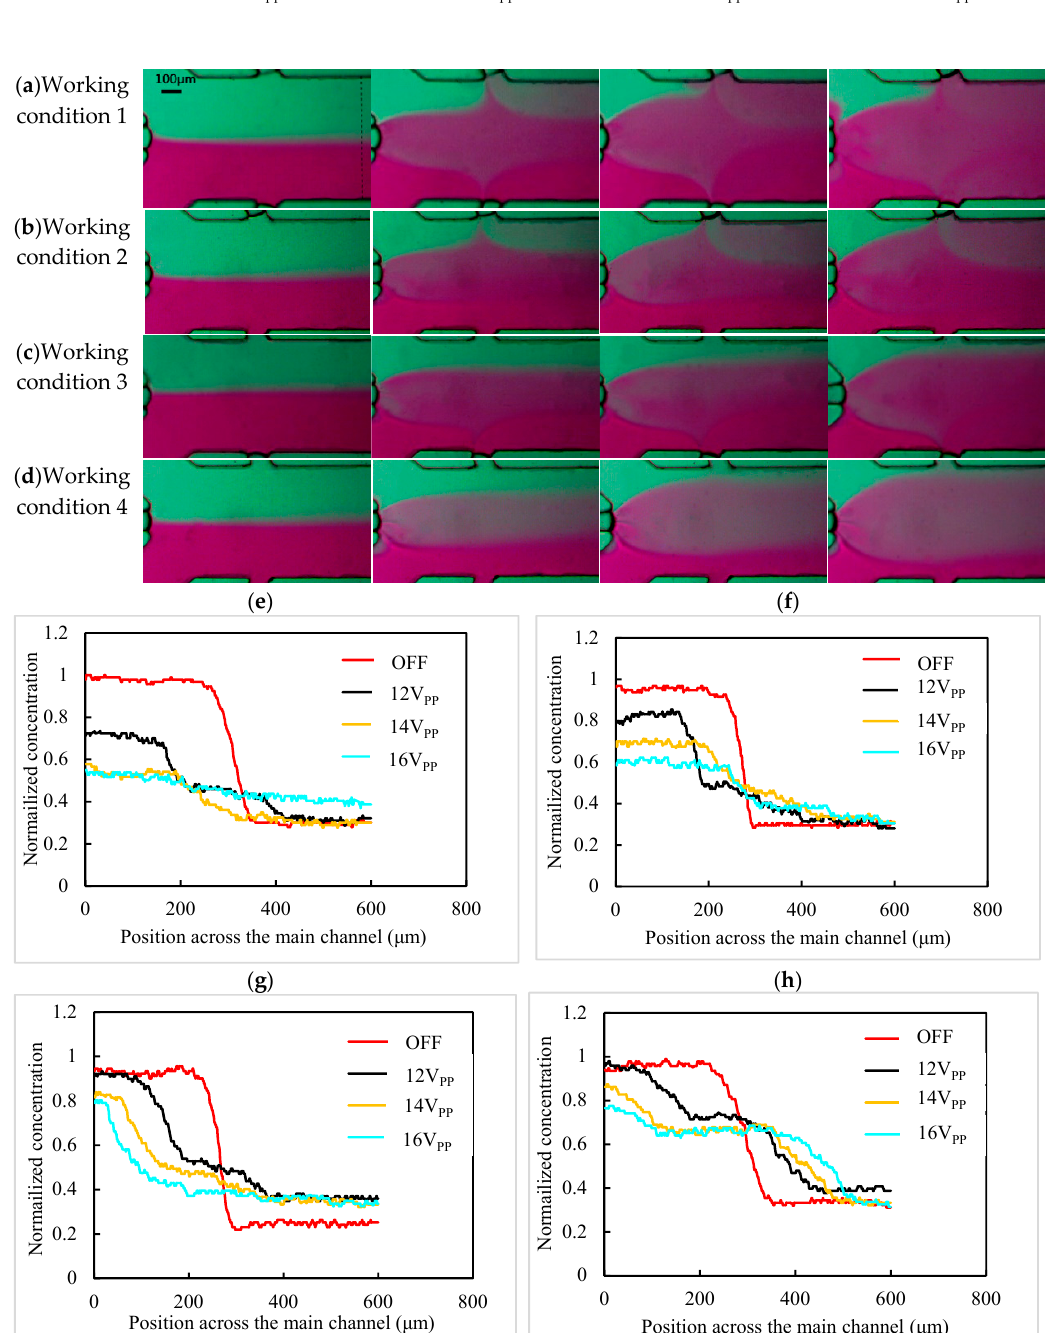
Figure 6. Characterization of concentration gradient in the main channel. ( a ) Images show three bubbles mixing the main channel solution. ( b ) Left and upper bubbles mixing the main channel solution. ( c ) Left and lower bubbles mixing the main channel solution. ( d ) Left bubble mixing the main channel solution under 0 V pp , 12 V pp , 14 V pp , and 16 V pp . The plots show the corresponding gradient profiles under different work conditions, namely: ( e ) work condition 1, ( f ) work condition 2, ( g ) work condition 3, and ( h ) work condition 4.